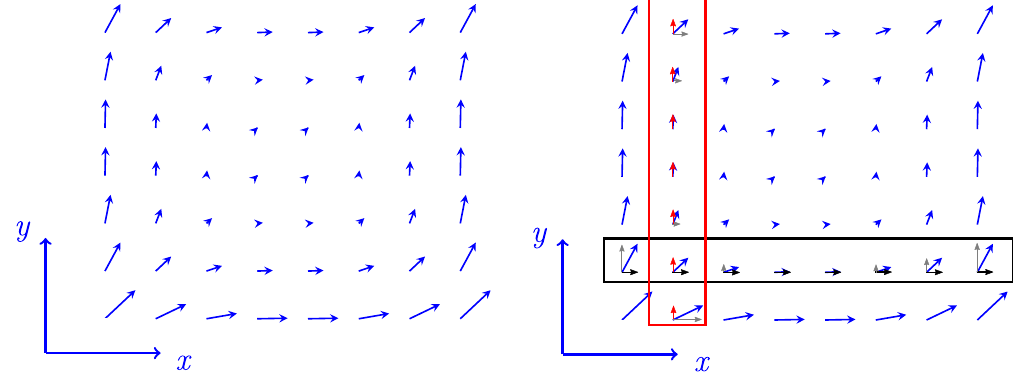
⃗ F FIG. 1. Left: Graphical representation of a two-dimensional vector field ð ⃗ r Þ with constant divergence. Students were asked whether divergence was zero or nonzero. Right: Visual cues highlighting the vector field decomposition and framing one row or column for evaluating ∂ = ∂ x and ∂ = ∂ y . For instance, the divergence can be estimated by judging the change of the black arrows in the black box and the red arrows in the red box, cf. Eq. (1). The fields are constructed to have constant zero or nonzero divergence